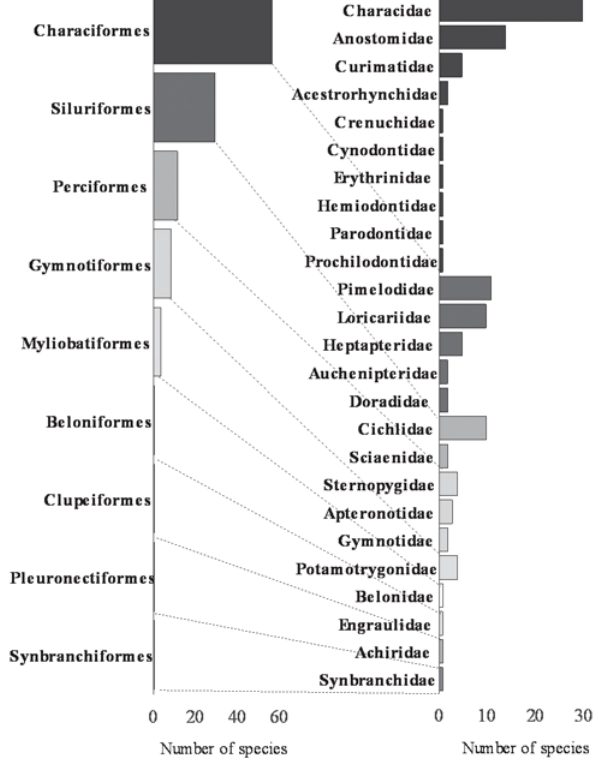
Fig. 2. Species number by order and family. Dotted lines de- limit the families in relation to the